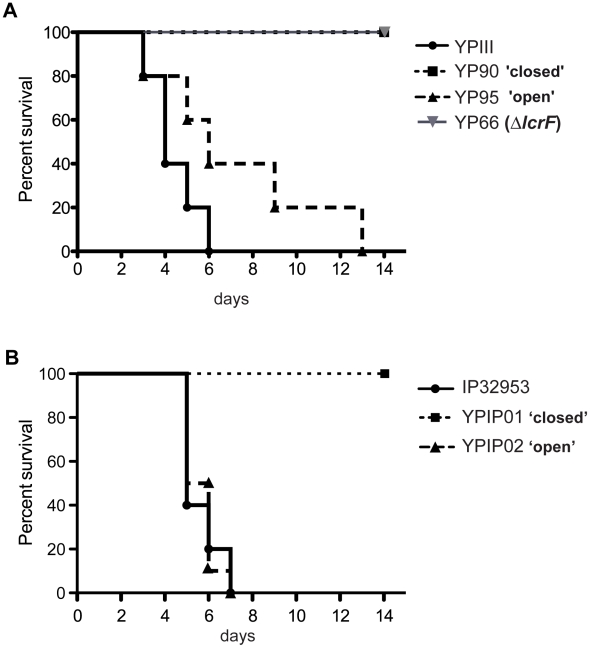

lcrF RNA thermometer variants affect survival of Y. pseudotuberculosis infected mice.(A) 2·109 CFU of Y. pseudotuberculosis YPIII (wildtype), the yscW-lcrF variants YP90 (UU-28/-27CC) and YP95 (GUU-30/-28AAA), and YP66 (ΔlcrF) were used to orally infect BALB/c mice (n = 10/strain). (B) 1·1010 CFU of Y. pseudotuberculosis IP32953 (wildtype), the yscW-lcrF variants YPIP01 (UU-28/-27CC) and YPIP02 (GUU-30/-28AAA) were used to orally infect BALB/c mice (n = 10/strain). Survival of the mice was monitored up to 14 days.